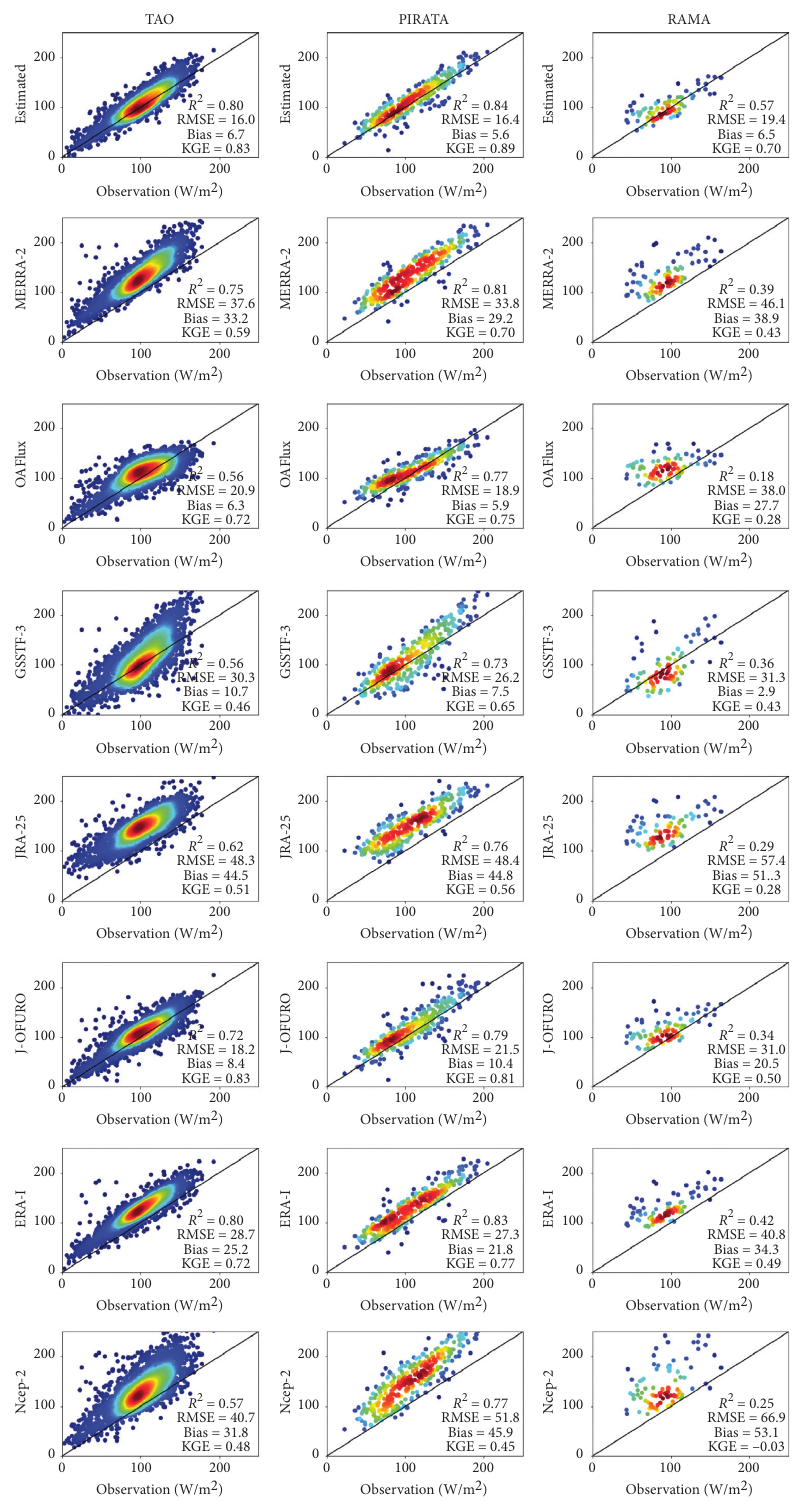
Figure 2: Comparison of monthly LHF estimates (units: W/m 2 ) against observations (67 buoy sites from the TAO array (first column), 18 buoy sites from the PIRATA array (second column), and 12 buoy sites from the RAMA array (third column)) in the period of 2003 to